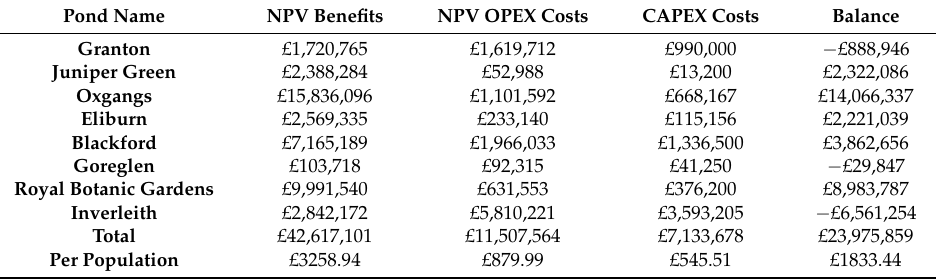
Table 4. Capital and maintenance costs for ponds, calculated following the guidance (surface area and pond volume for treatment) from [27]. The Net Present Value (NPV) benefits refer to the